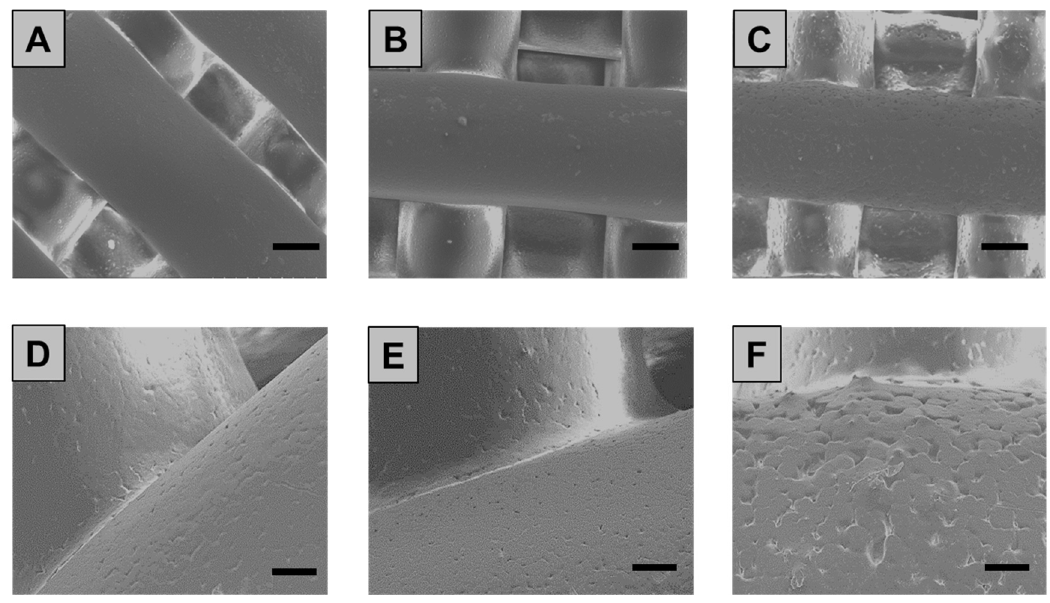
Figure 4. SEM images of the 3D printed PCL ( A , D ), PCL/10Sr-nHA ( B , E ) and PCL/Sr20-nHA ( C , F ) scaffolds (( A – C ) scale bar = 200 μ m and ( D – F ) scale bar = 50 μ m).